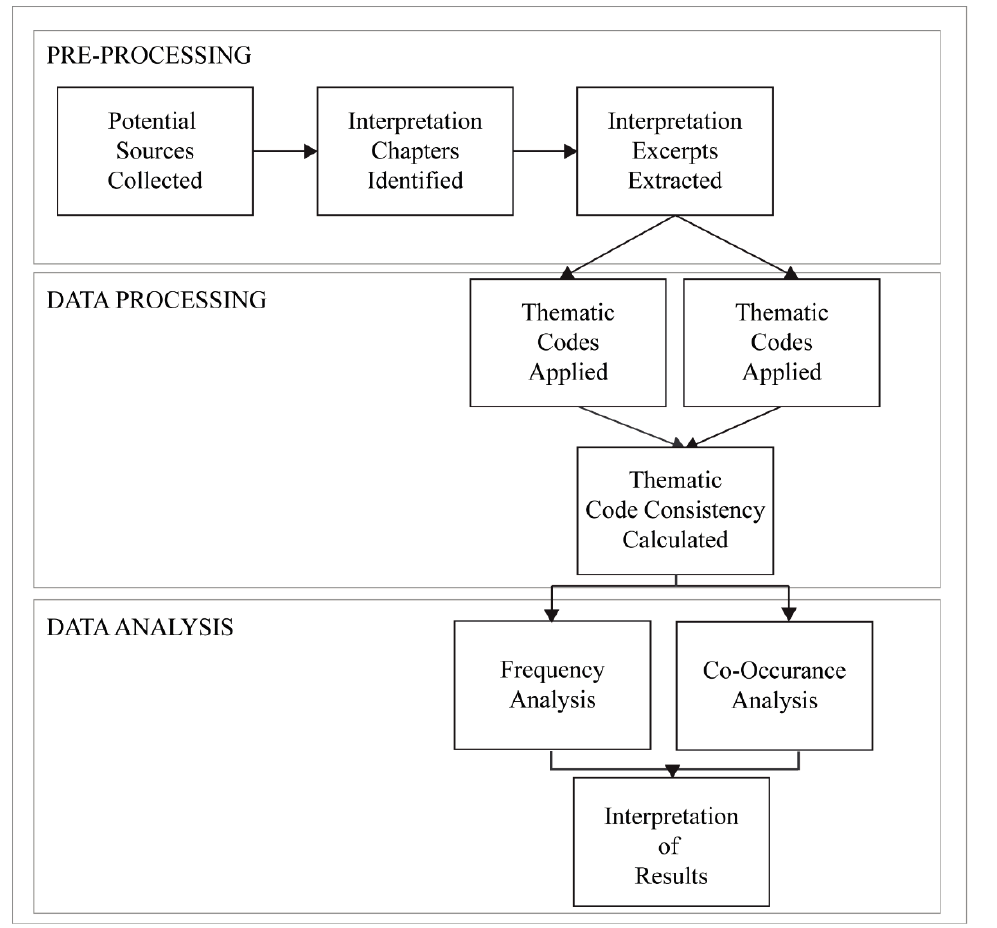
Figure 1. The coding process as outlined in this